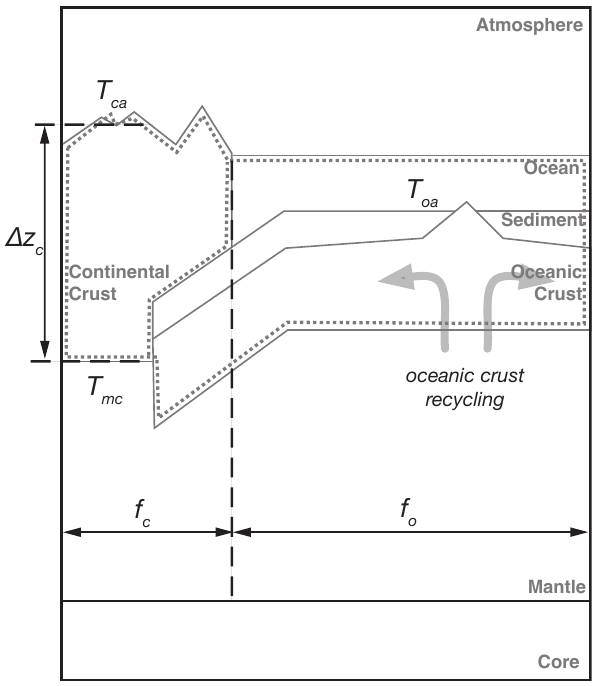
Fig. 7. Oceanic crust recycling: Heat flows from the mantle out into space via continental and oceanic crust. The proportion of continen- tal to oceanic crust is denoted with f c and f o respectively where f o =1 − f c . The total thickness of continental crust is denoted with 1z c . The upper mantle temperature is denoted with T mc , temper- ature of the oceanic crust – ocean boundary is denoted with T oa and temperature of the continental crust – atmosphere boundary is denoted with T oa